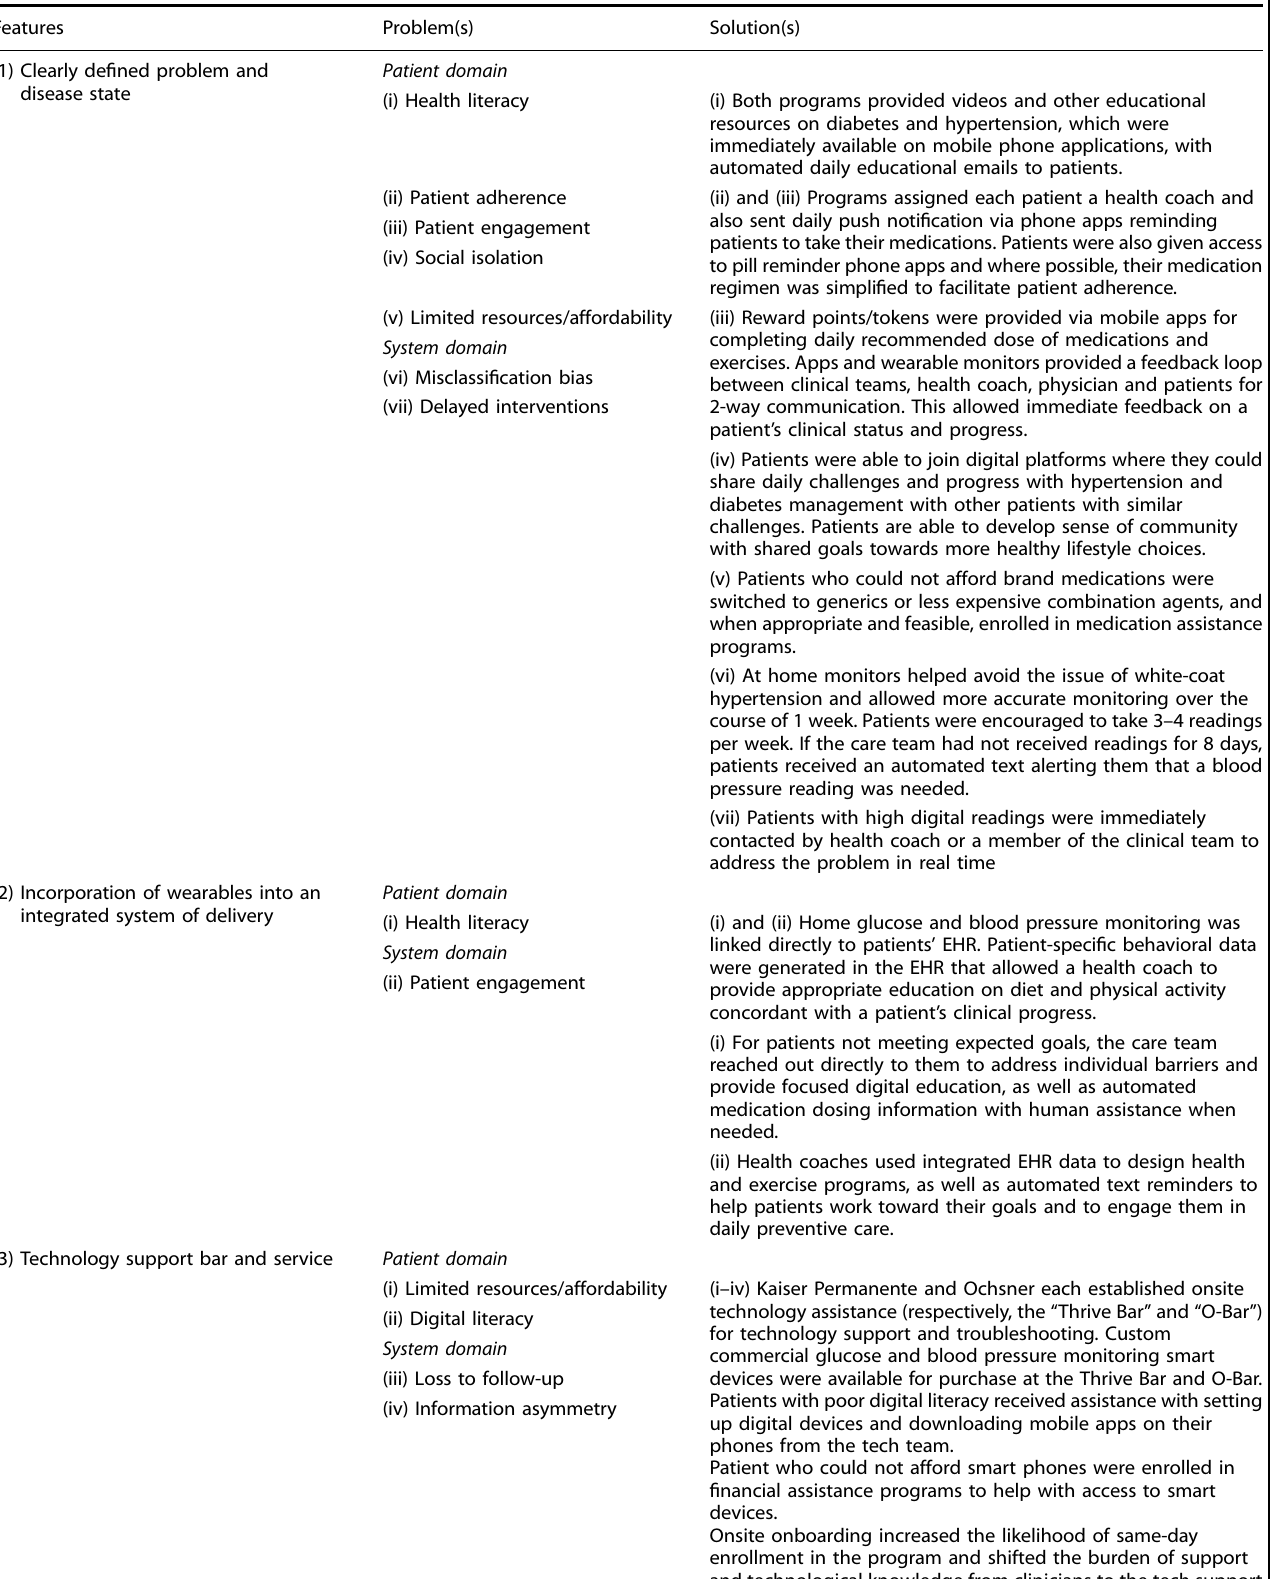
Table 1. Examples of solutions to problems addressed by each of the seven identi fi ed features of successful digital health interventions that include